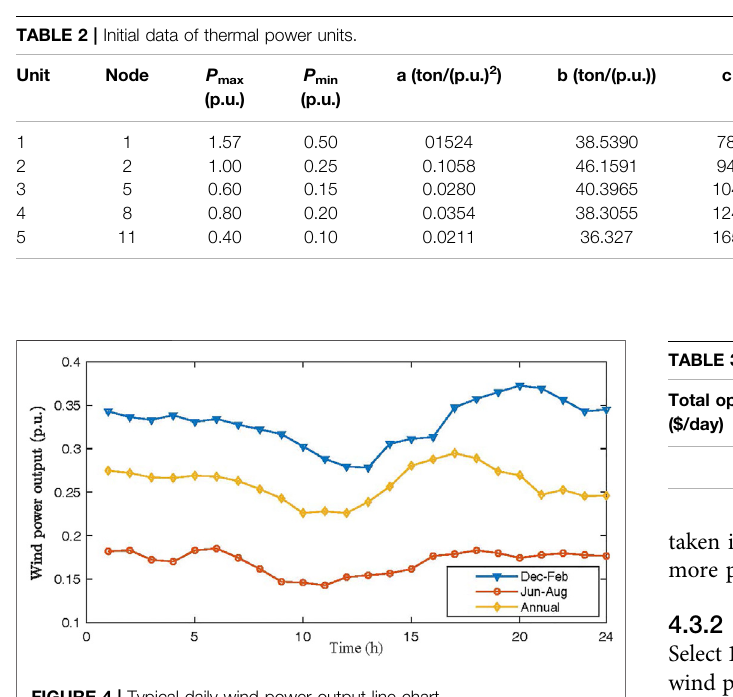
FIGURE 4 | Typical daily wind power output line chart.